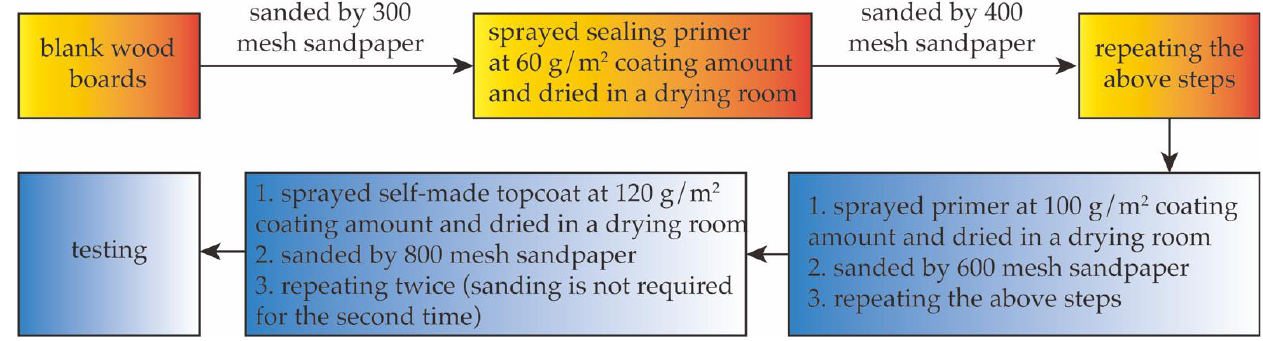
Figure 1. Process flow chart of spraying times experiment.